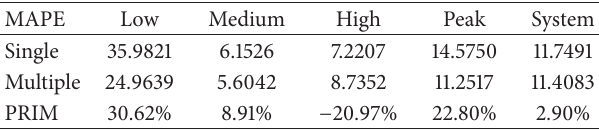
Table 3: Performance evaluation results of MAPE between the single and the two-stage multiple SVM in June